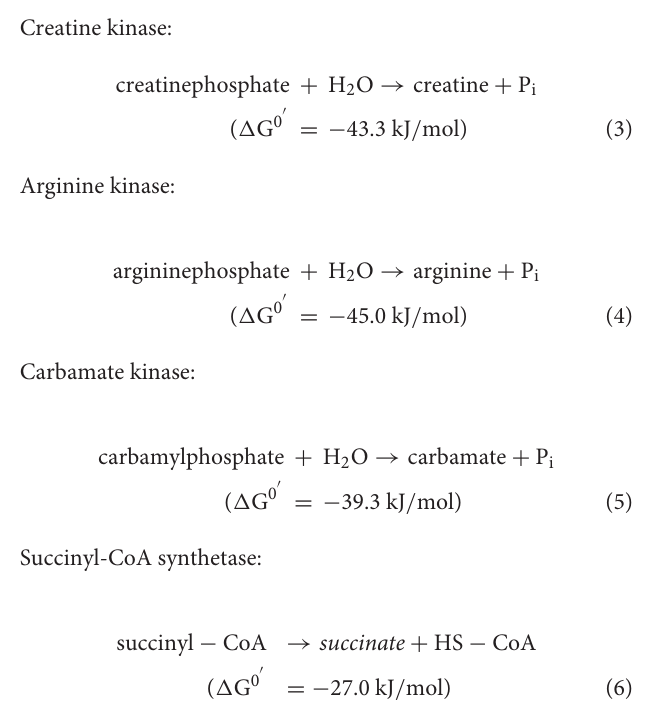
FIGURE 7 | Ech gene-cluster of representative mesophilic anaerobes. Ech genes are highly distributed in the mesophilic Butyrivibrio clade. Typical anaerobes are for example Pseudobutyrivibrio ruminis , Butyrivibrio proteoclasticus , Pseudobutyrivibrio xylanivorans or Butyrivibrio fibrisolvens . Here shown are the Ech gene-cluster-comparison against representative archea M. mazei and M. barkeri . Ech gene-cluster of mesophilic anaerobes show similar genetic